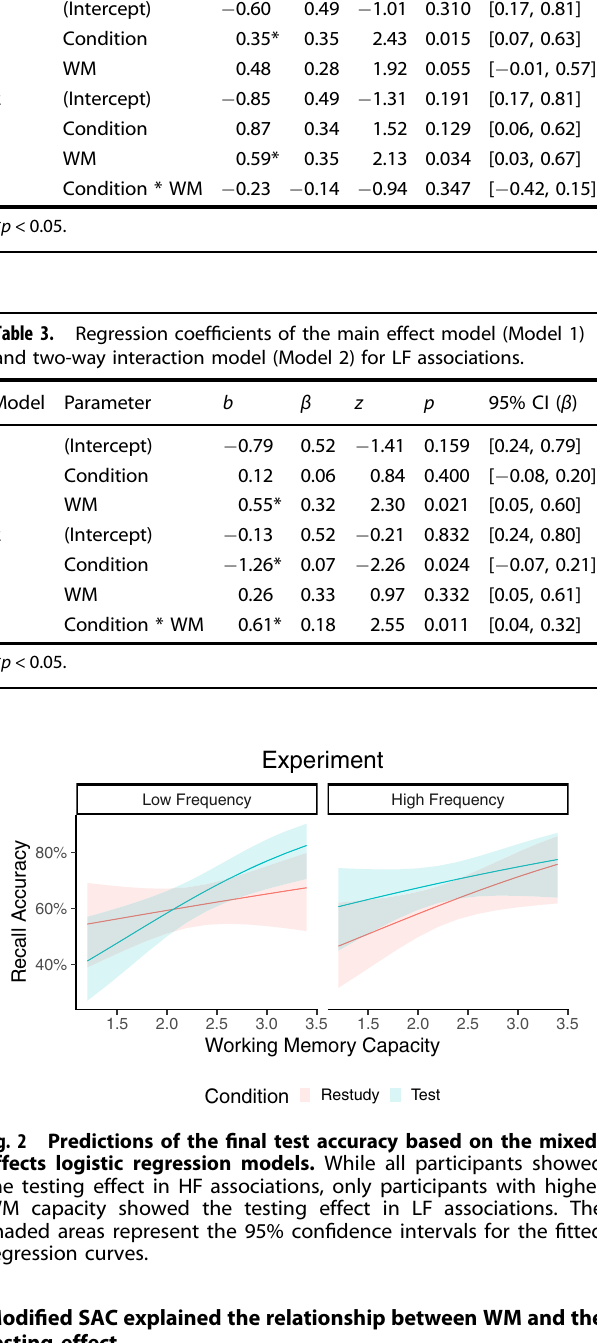
key fi nding of a WM capacity by condition interaction in LF